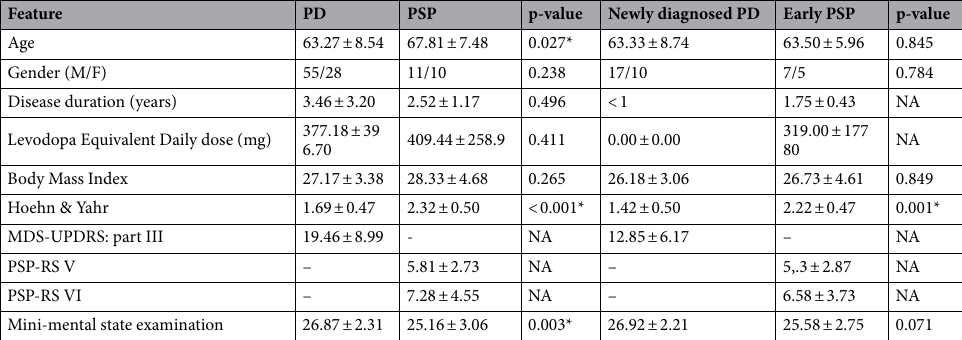
Table 1. Comparison of demographic and clinical features between PD and PSP patients. NA not applicable, PD Parkinson’s disease, PSP progressive supranuclear palsy, MDS-UPDRS movement disorder society